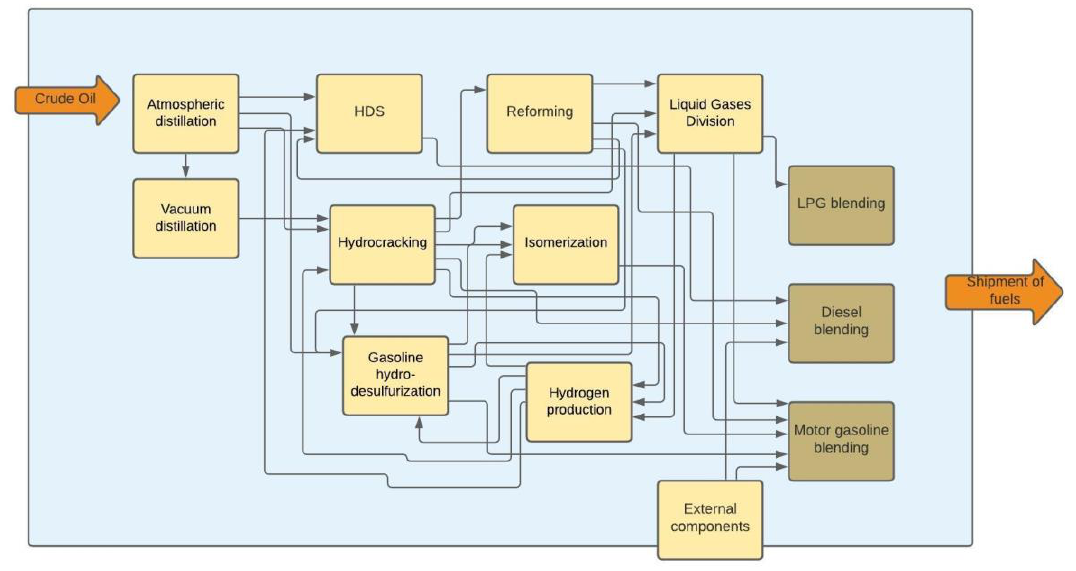
Figure 1. The generic overview of refinery installations.